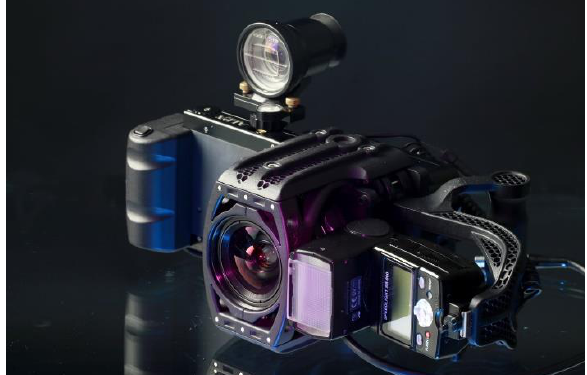
Figure 2. ALPA 12 FPS add|metric front view